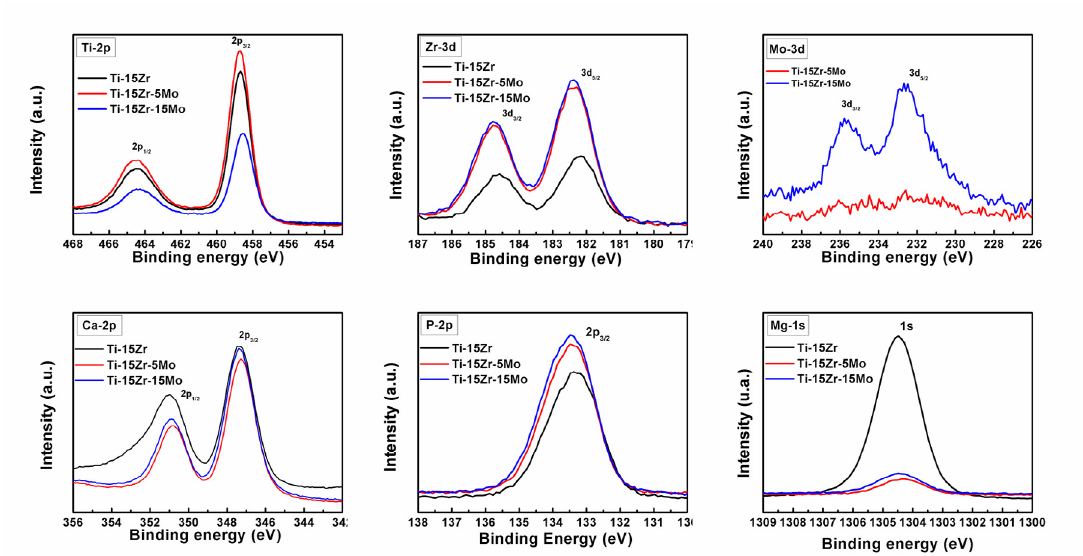
Figure 8: High resolution XPS spectra of the alloying and bioactive elements. Table 2. Semi-quantitative XPS chemical composition of the bioactive elements. As-cast samples